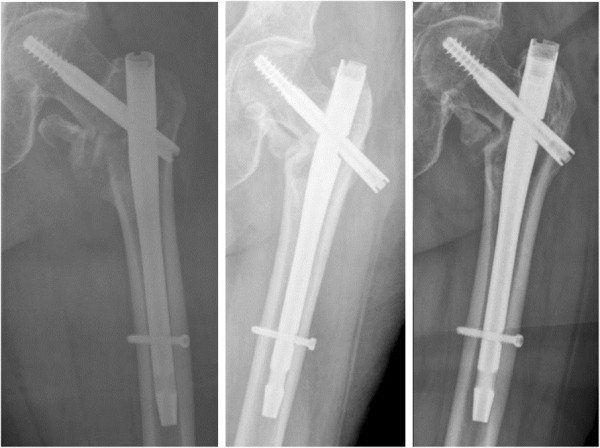
Patient with tract irritation: postoperative, during follow-up and after revision with change of the femoral neck screw.